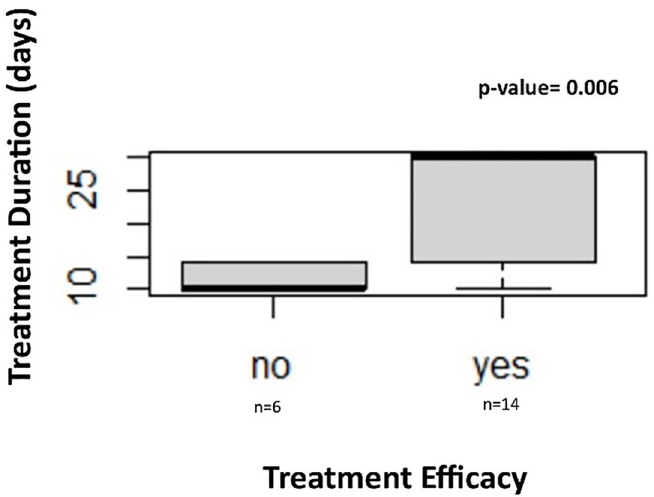
Fig 6. Antibiotic treatment duration and efficacy for chronic bacterial